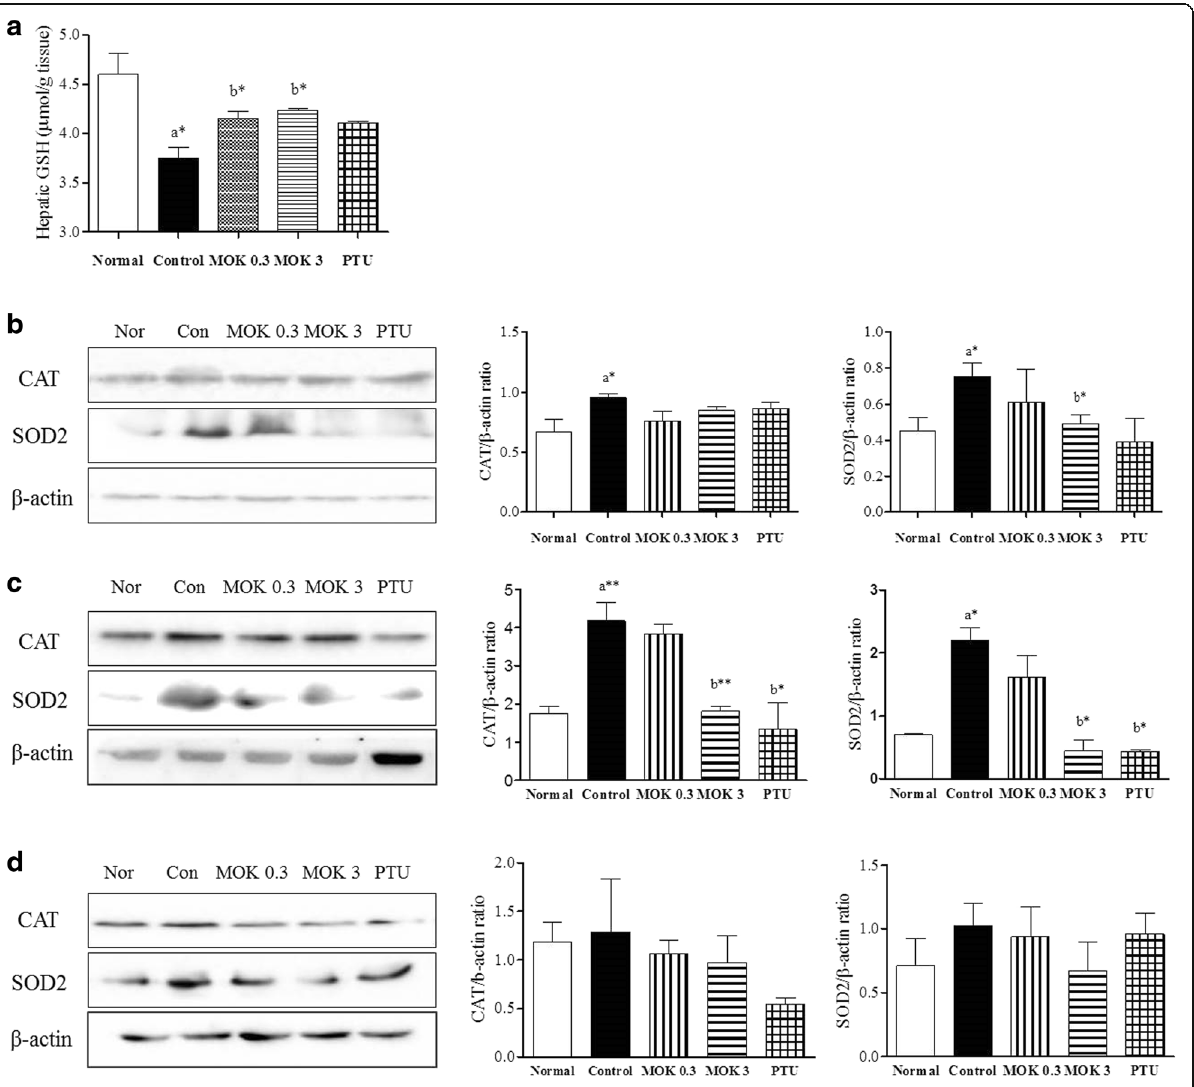
Fig. 8 Effect of MOK pharmacopuncture on the oxidation in liver, brain, and heart tissues ofLT4-induced hyperthyroidism rats. MOK pharmacopuncture was subcutaneously administration once daily for 2 weeks, and measured the levels of GSH ( a ) from the liver of rats by ELISA. Theexpression of catalase (CAT) and SOD2in the liver ( b ), brain ( c ), and heart ( d ) tissues using Western blot. Data are presented as mean±SD ( n =5 per each group). * P <0.05, ** P <0.01 and *** P <0.001 vs normal ( a ) or control ( b ). Normal, normal group; Control, LT4-induced hyperthyroidism group; MOK 0.3, MOK 0.3 mg/kg-treated group in control; MOK 3, MOK 3 mg/kg-treated group in control; and PTU, PTU 10 mg/kg-treated group as a reference